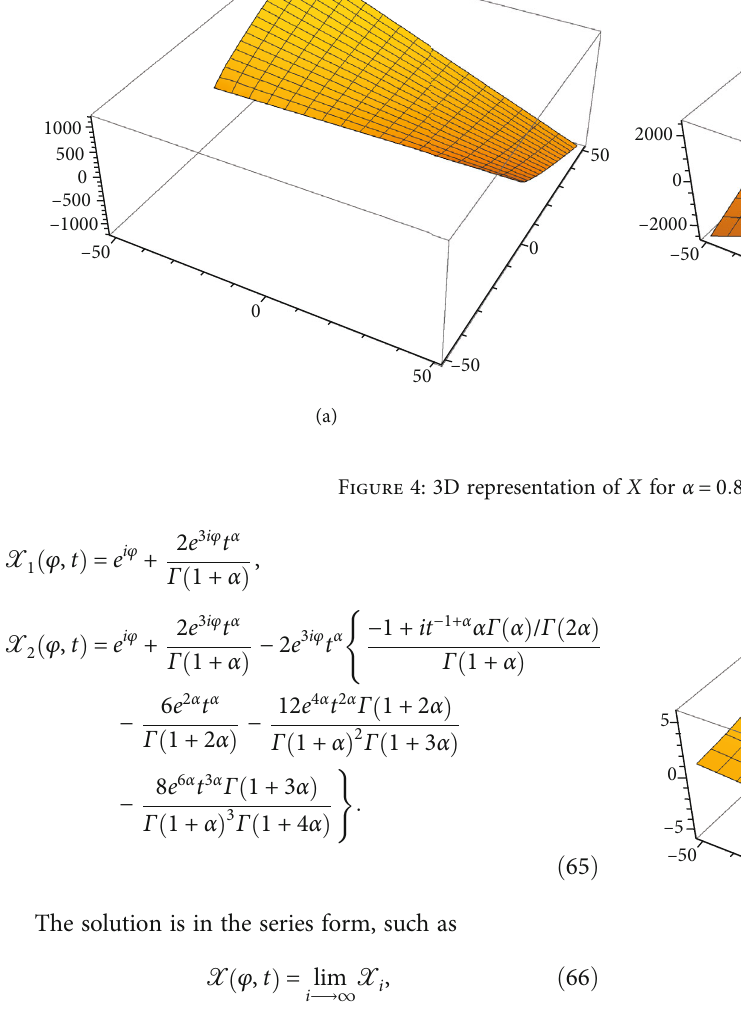
Figure 5: 3D representation of the exact solution.